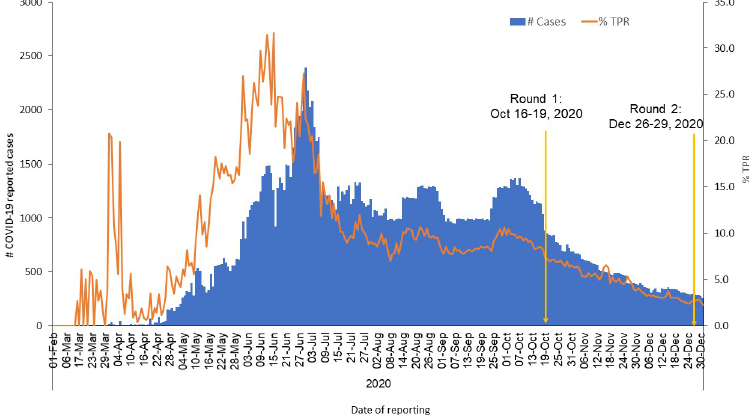
Fig 2. COVID-19 cases, test positivity rate (%), & date of surveys, Chennai, India, October-December